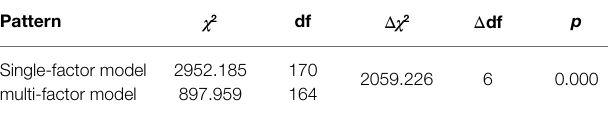
TABLE 2 | Comparison of single- and multi-factor